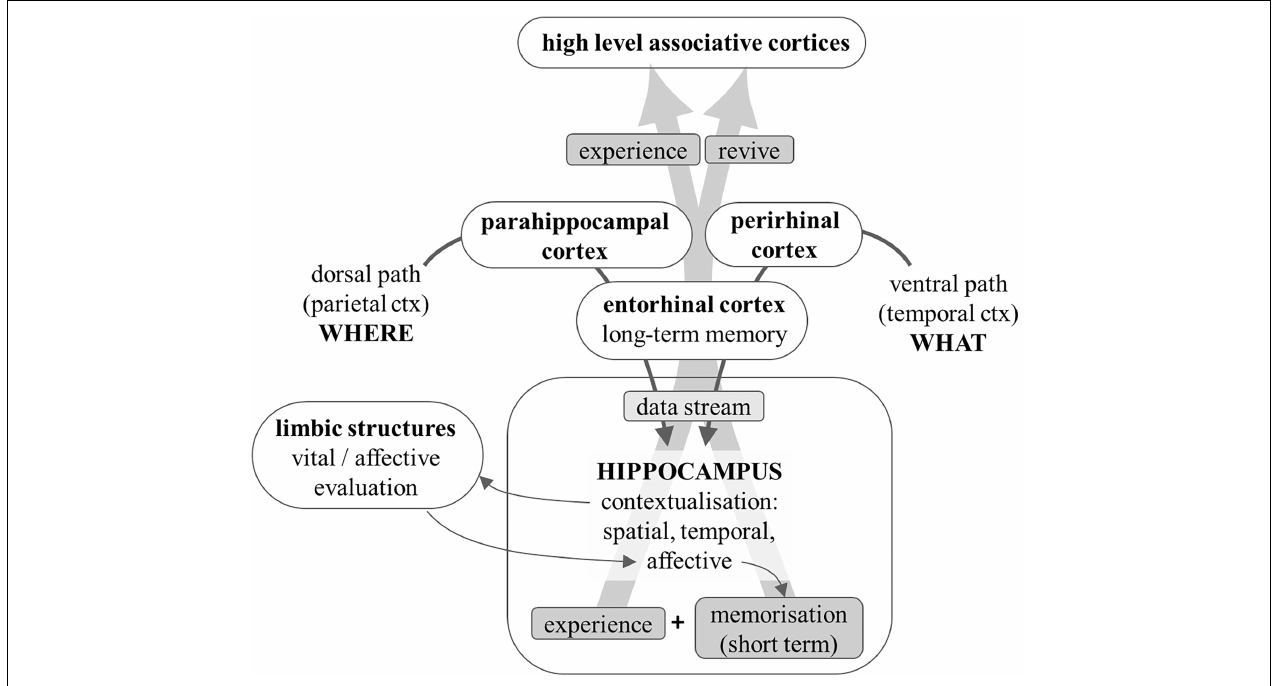
FIGURE 5 | Diagram that shows how information is transformed into a personal experience . Data about object identification and location is relayed to the hippocampus. The latter provides contextualisation: spatial, temporal (which transforms sequences of events into episodes), and semantic. The strong bidirectional connections with limbic structures help the latter to emotionally evaluate the contextualized situation; the emotional coloring adds affective contextualisation and enhances memorization by the hippocampus. The experience so personalized is reflected onto the peri-hippocampal cortices that relay it to higher level associative areas and can store it as a long-term memory of the comprehensive and personal vital